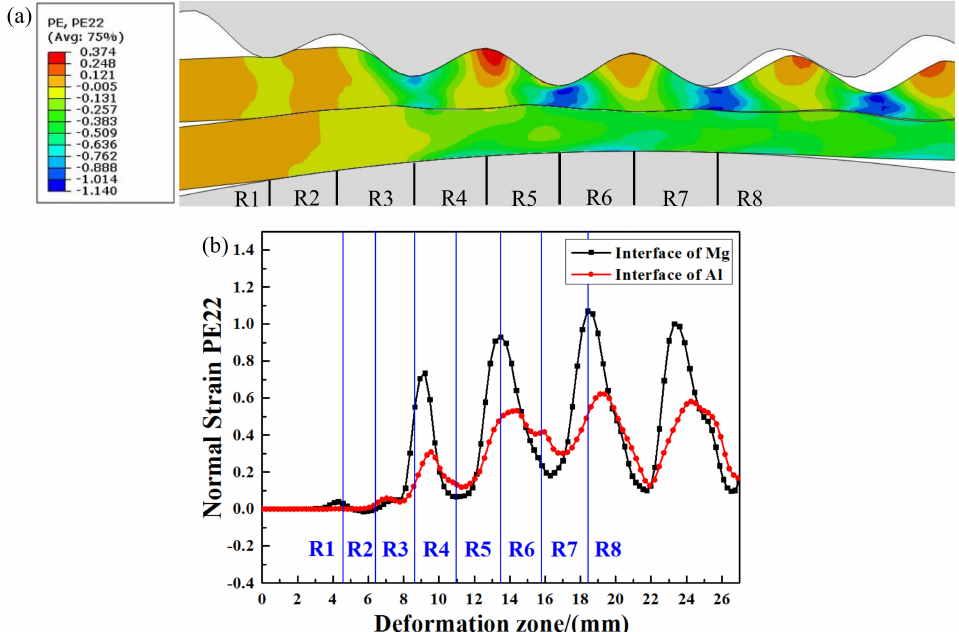
Figure 6. Normal strain distribution of interface metals in corrugated rolling deformation zone: ( a ) normal strain nephogram, ( b ) normal strain